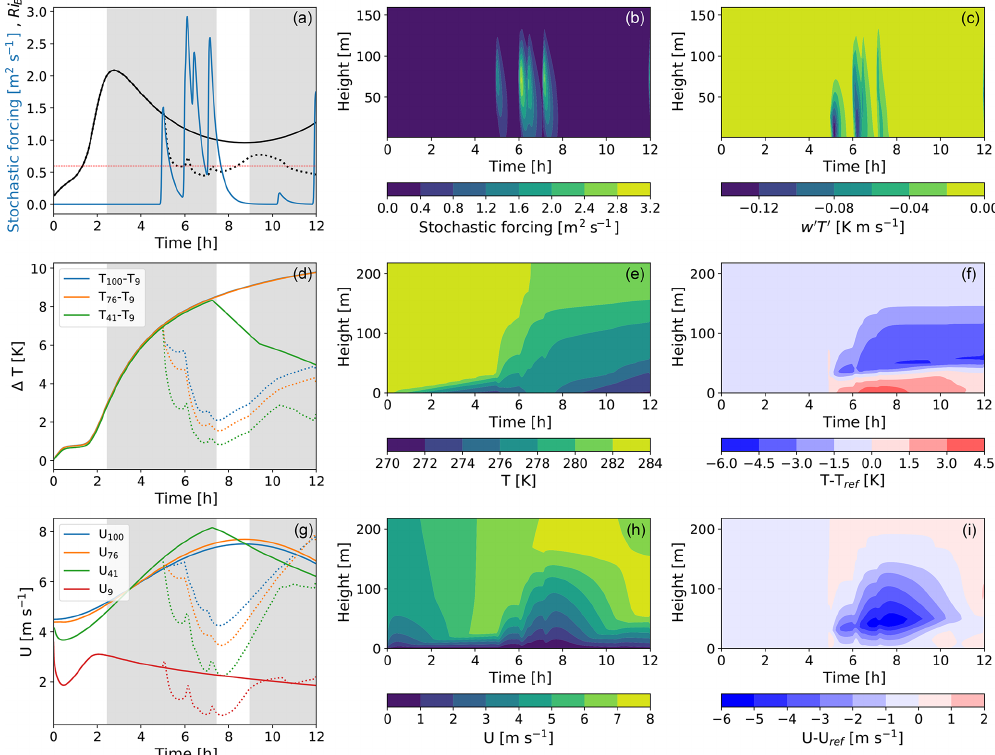
Figure 10. One realization of a 12h simulation of the evolution of the nocturnal boundary layer (with time zero being the time the net energy surface flux becomes negative) using the proposed parameterization. Times when S is in the vSBL are highlighted in grey. Top row from (a) to (c) : Ri B (solid and dotted black lines, respectively, for the reference experiment without the stochastic parameterization and the experiment with the stochastic parameterization) and the strength of the stochastic forcing (blue line; a ); the structure of the stochastic forcing function (b) and the resulting kinematic heat fluxes (c) . Middle row from (d) to (f) : the stratification between different levels (d) , the temperature profiles (e) , and the difference in the temperature field to the reference experiment without the stochastic parameterization (f) . Third row from (g) to (i) : wind speeds at different heights (g) , wind speed profiles (h) , and the difference in the wind field to the reference experiment without the stochastic parameterization (i)